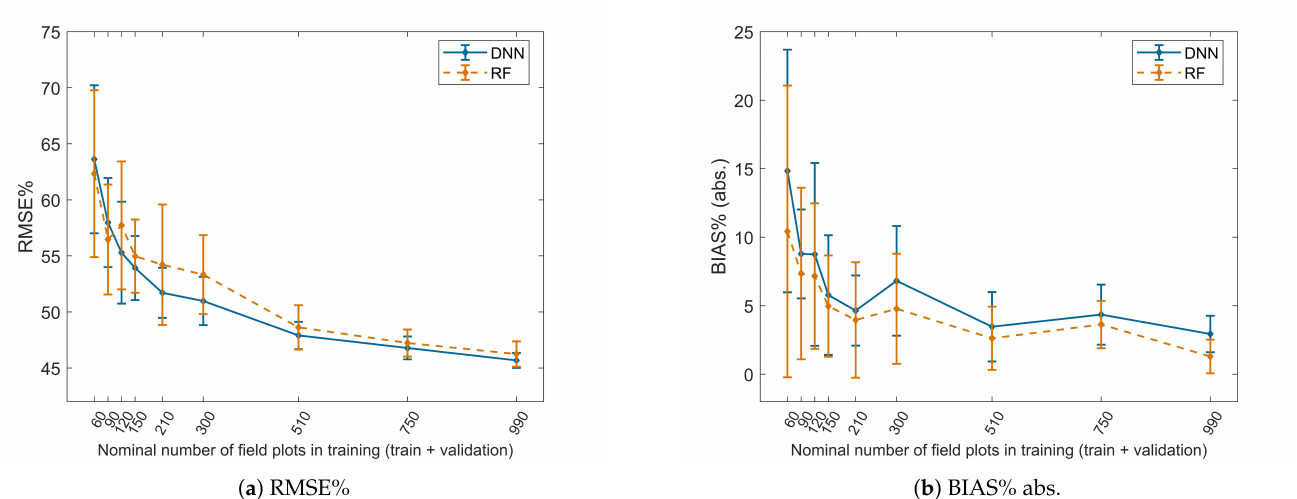
Figure 7. Test set relative root-mean-square error (RMSE%) and average of relative bias absolute values (BIAS% abs.) for DNN and RF models with different nominal amounts of field plots used in training+validation sets. The whiskers show the standard deviation (1 σ ) of the error from the 10 iterations of same nominal number of field